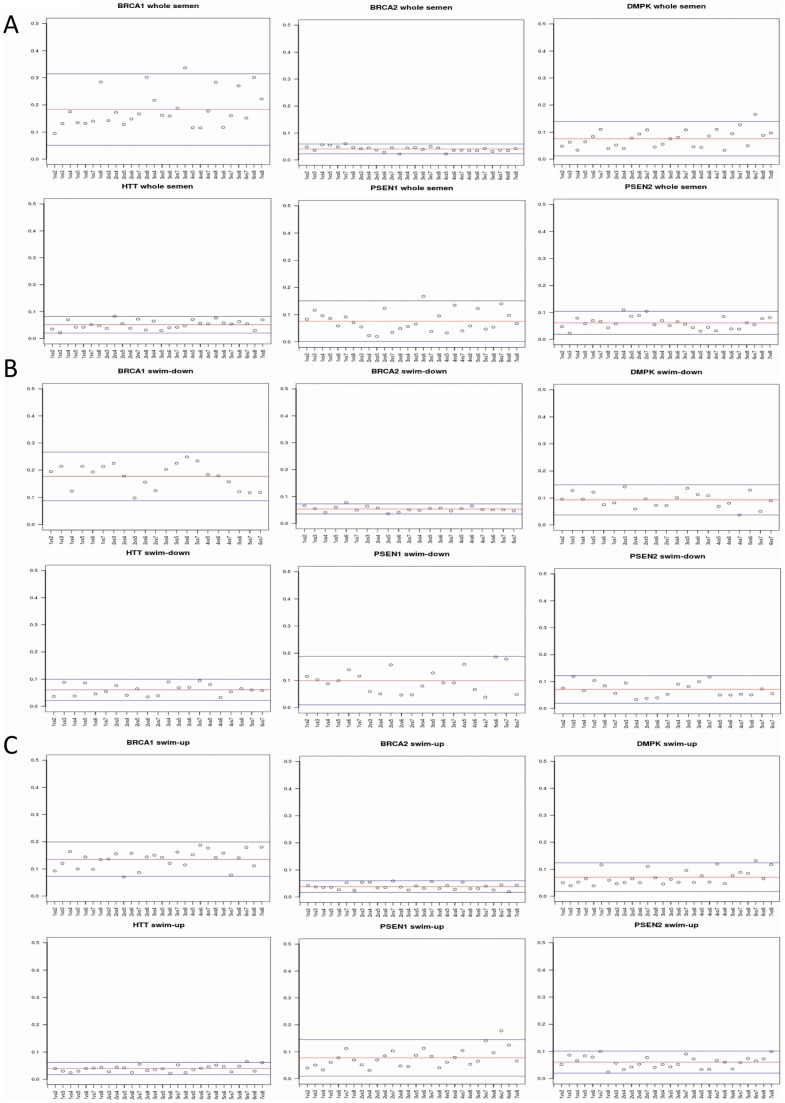
Intra-group epigenetic distances for the promoters of
BRCA1, BRCA2, HTT, DMPK1, PSEN1 and
PSEN2 genes.This distance represents the net dissimilarity of DNA methylation
profiles between two sequences: the higher the distance, the more
dissimilar are the compared samples. Different individuals were
crossed with each other and Euclidean distances were calculated for
beta-values of CpG sites as a marker of inter-individual variability
in three different sperm subpopulations: A) Whole sperm population;
B) swim-down and C) swim-up fractions. Numbers on the X axis
indicate the identity of the pair-wise comparisons inside the
experimental group: individuals EC01, EC07, EC10, EC12, EC14, EC16,
EC18 and EC10 are numbered 1 to 8. Distance values are displayed on
the Y axis. The top and bottom blue guidelines represent the 0.025
and 0.975 quartiles, while the red guideline represents the mean
distance value.